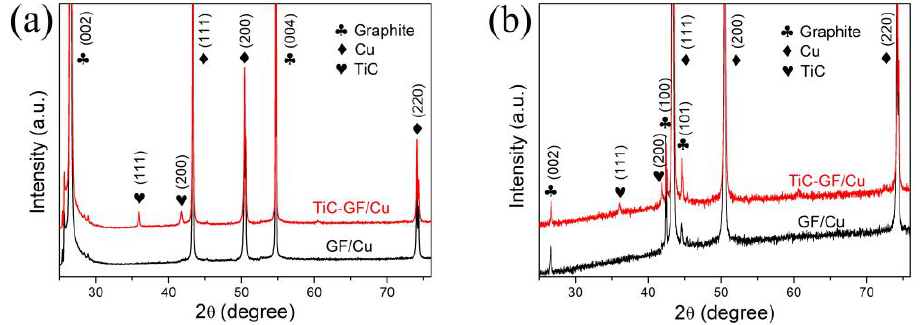
Figure 5. XRD results of the TiC-coated and uncoated graphite flake/Cu composites in ( a ) X - Y plane, ( b ) Z direction.